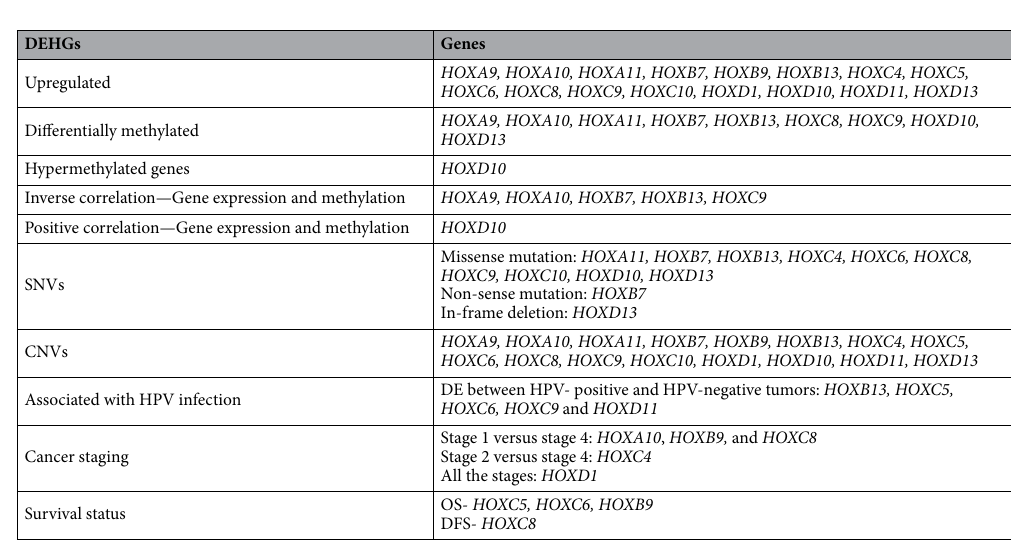
Table 1. The differentially expressed HOX genes in association with head and neck squamous cell carcinoma. All the genes mentioned in this table are statistically significant in the corresponding analysis performed ( p ≤ 0.05). Supplementary Tables S1–S6 shows the fold change values, sample size, and statistical significance of all the analysis